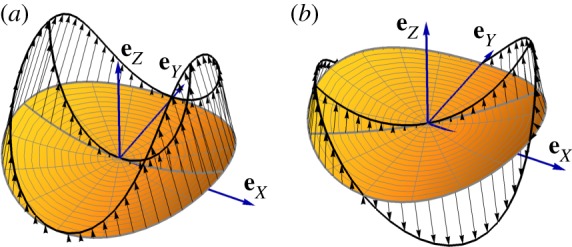
Velocity modes of the disc associated with variations of the curvature amplitude (a) and the curvature axis orientation (b), see equations (2.6)–(2.8).